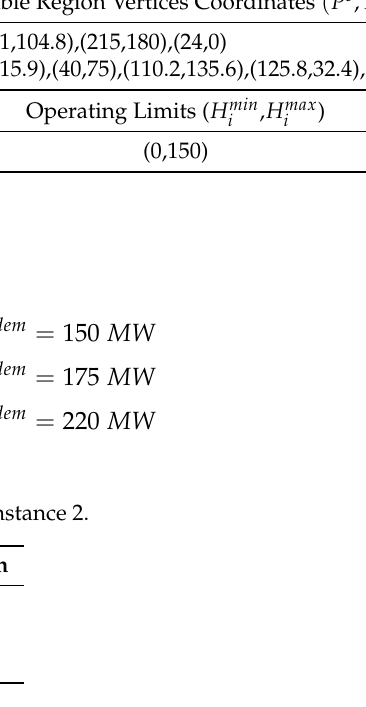
Table A4. Cost functions and operating limits of generating units for test instance